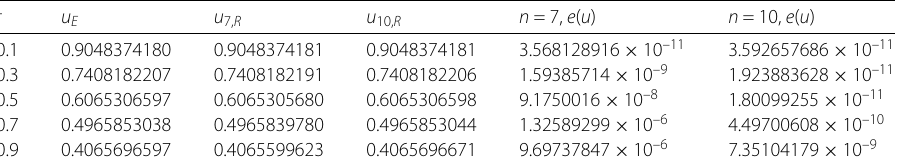
Table 8 Numerical result of Example